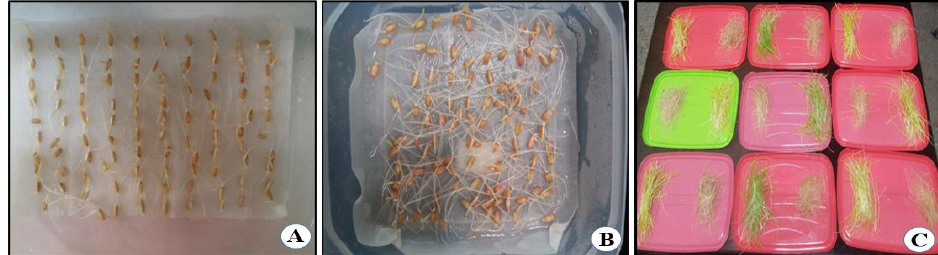
Figure 1. First experiment. Root emergence ( A ), root elongation ( B ), and excised root and stem preparations for subsequent measurements ( C ).